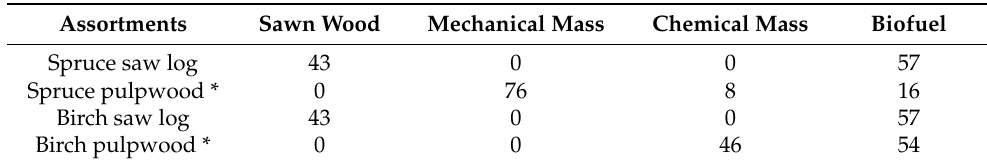
Table 1. Percentages of end product subgroups for saw log and pulpwood; *—end product percent- ages from Pukkala [12].